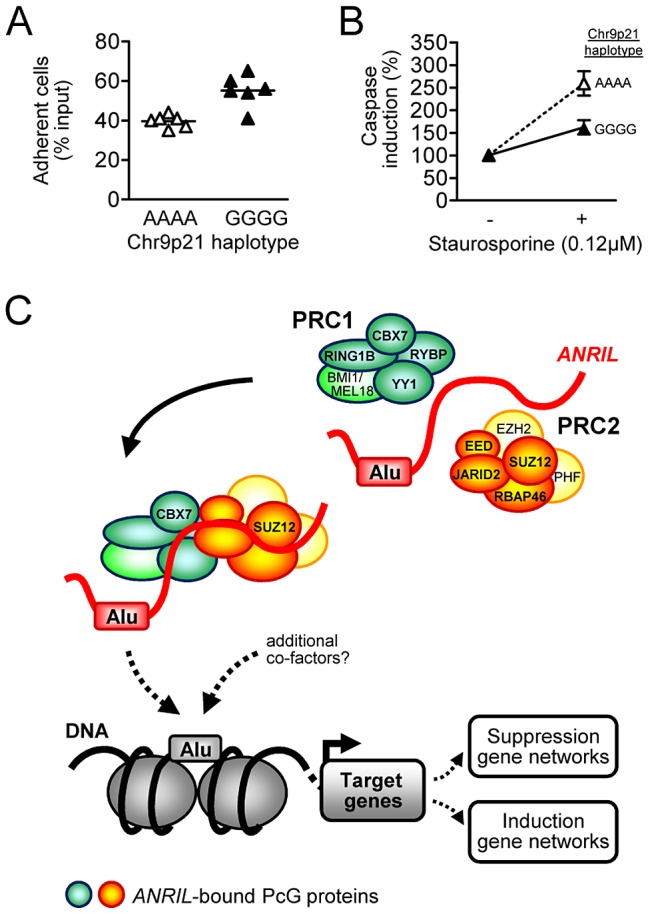
Validation of ANRIL-associated cellular effects in primary cells and schematic of molecular scaffolding by ANRIL.(A) PBMC from carriers of the Chr9p21 CAD-risk allele defined by rs10757274, rs2383206, rs2383297, and rs10757278 (n = 8) showed increased adhesion (P = 0.001) and (B) decreased apoptosis (P = 0.008) compared to cells of carriers of the protective allele (n = 8). (C) Schematic of molecular scaffolding by ANRIL mediated through potential chromatin-RNA interaction by Alu motifs.